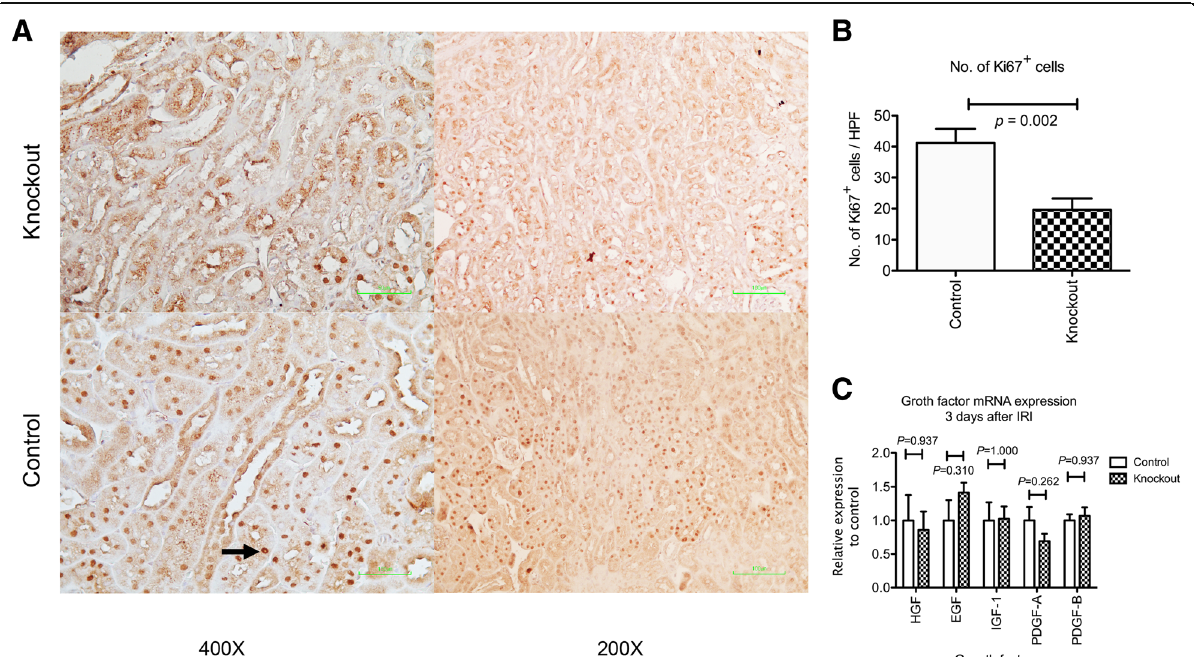
Fig. 5 a & b Ki67 staining and semi-quantitative analysis of Ki67 positive tubular cells 3 days after IRI in the control and knockout mice. Fewer Ki67 positive cells were observed in the knockout mice. Arrow indicates Ki67 positive cells ( N = 8 per group, P = 0.002) c Growth factor genes expression in the whole kidney. No difference of the gene expression of HGF, EGF, IGF-1, PDGF-A and PDGF-B was observed between the Angpt1 knockout and control mice ( N = 6 per